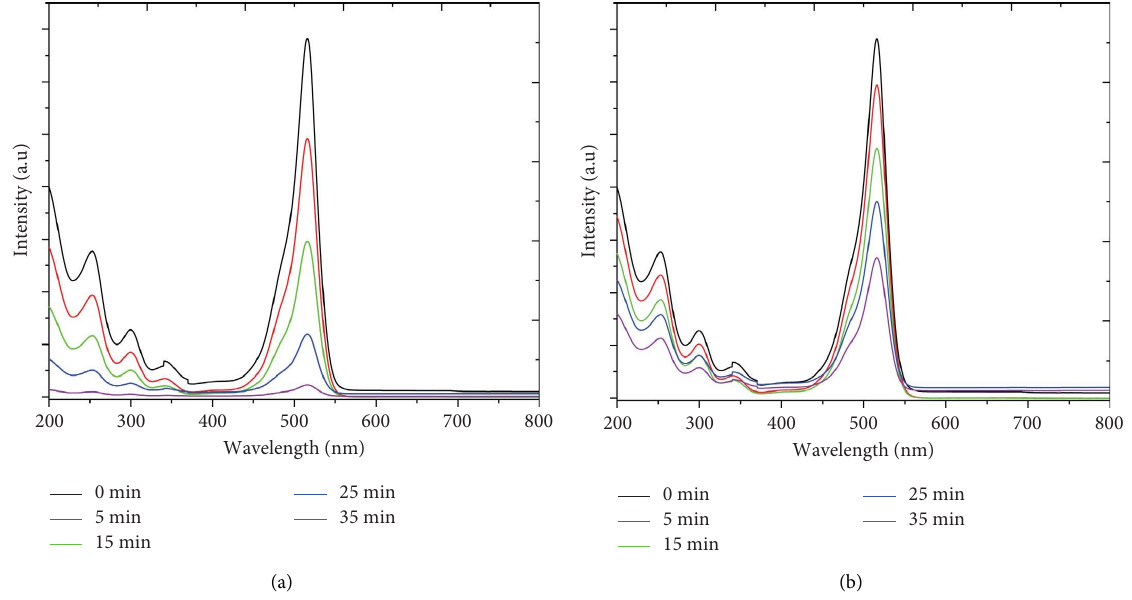
Figure 6: Eosin yellowish degradation studies the efect of light exposure: (a) visible light and (b) UV